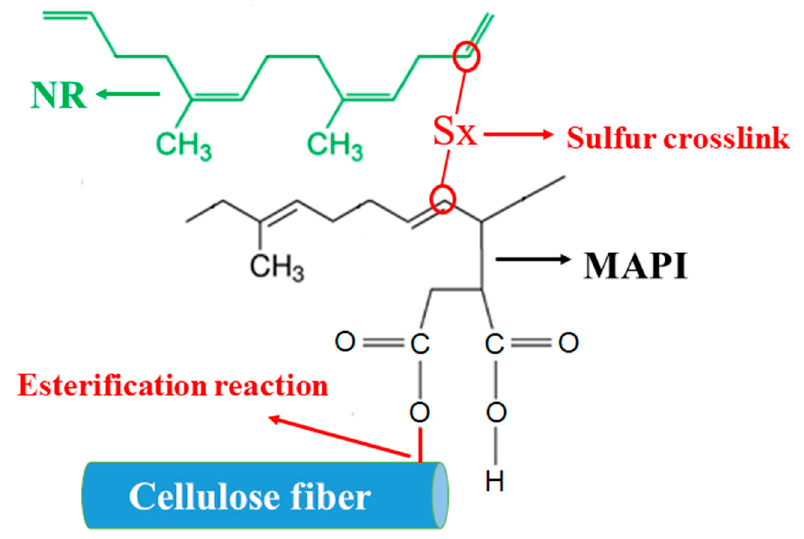
Figure 9. Mechanism of possible crosslinking reaction between cellulose modified with maleic anhydride grafted to polyisoprene (MAPI) and NR chains [102].